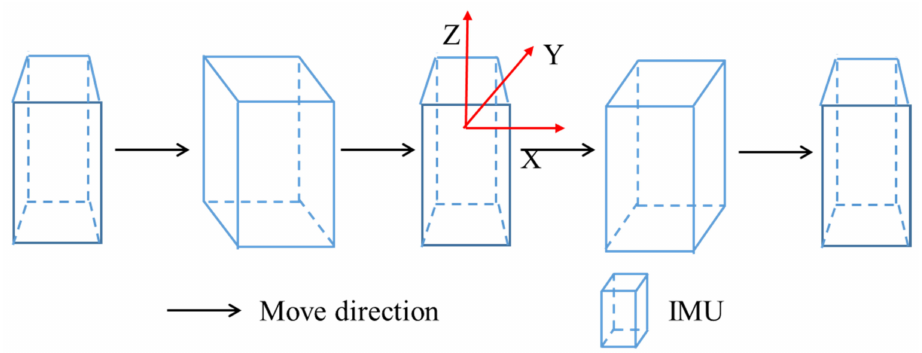
Figure 7. Decomposition diagram of waist